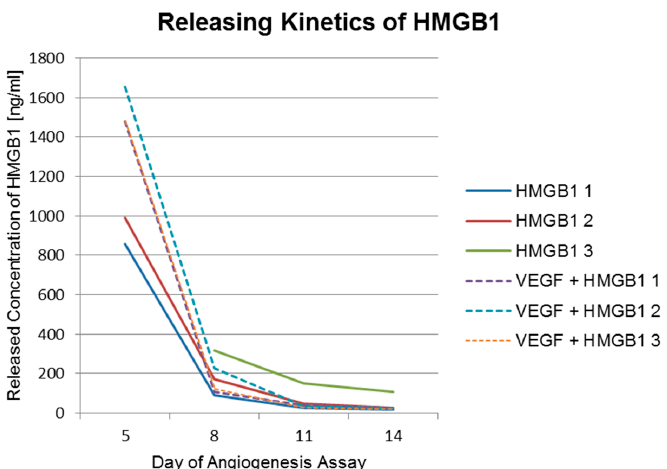
Figure 9. Released amounts of HMGB1. Releasing kinetics of HMGB1 from titanium implants coated with PCL and functionalized with HMGB1 and from titanium implants coated with PCL and functionalized with VEGF and HMGB1 (dashed lines). The concentration of HMGB1 released from titanium PCL scaffold HMGB1 3 (green line) was above the detection limit of 1668 ng/mL at day 5. Therefore, no result for this day can be shown.